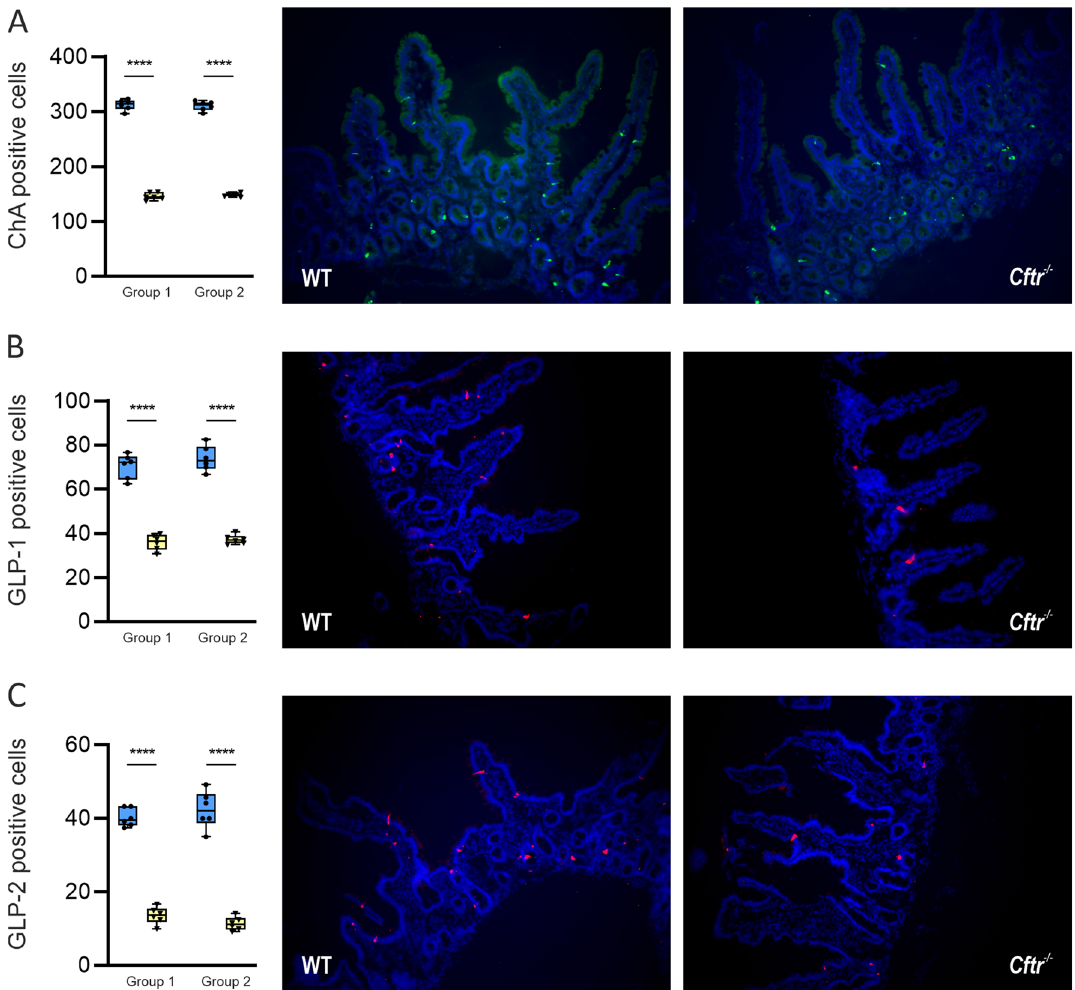
Figure 5. Expression of enteroendocrine cells (EECs) in mouse ileal tissue. Quantification of cell numbers and representative images of ( A ) EECs with ChA positive cells stained green and ( B & C ) L-type EECs with GLP-1 and GLP-2 positive cells stained red in wild-type (blue circle, blue) and CFTR-null ( Cftr −/− ) (yellow inverted triangle, yellow) mice from group 1 and group 2. Nuclei are stained blue with 4’,6-diamidino-2-phenylindole (DAPI). Box and whisker plots represent number of cells counted expressing ChA or GLP-1/2 as median ± 95% CI (n = 6 for each mice group). Statistical significance was determined by One-way ANOVA with differences between means identified using Tukey’s multiple comparison post hoc test; **** P < 0.0001. Images are 200 ×